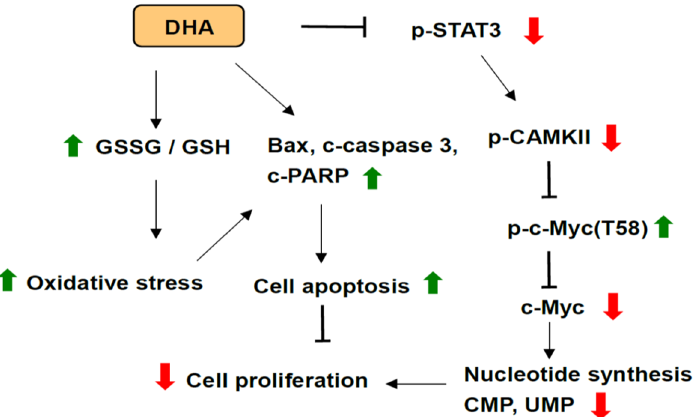
Figure 7. Proposed mechanisms of DHA-mediated suppression of STAT3/CAMKII signaling path- ways, c-Myc expression and nucleotide synthesis as well as induction of apoptosis in human PDAC cells. Green arrows indicate an increased level. Red arrows indicate a decreased level.